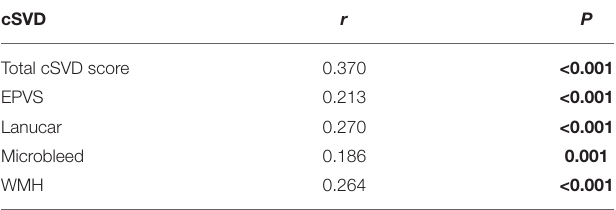
TABLE 2 | Correlation analysis of cSVD and MTA. cSVD r P